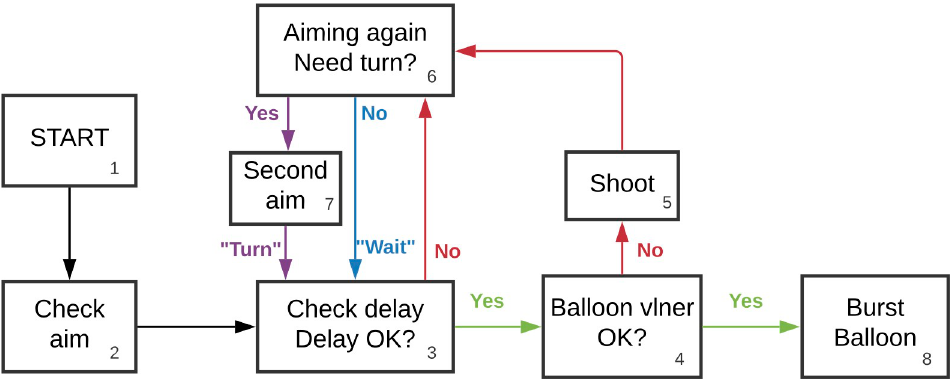
Fig 2. Description of ACT-R operators in Auto Orbit . The diagram is displaying the order in which operators (action rules based on the instructions) were retrieved from the start (balloon respawn–box 1) to the end (balloon burst–box 8) of a game cycle. The “check aim” operator (box 2) checked whether the spaceship was correctly aimed at the balloon. The “check delay” operator (box 3) assessed whether the temporal module time tracker was greater than a given threshold. The “balloon vlner” operator (box 4) assessed whether the vulnerability of the balloon was high enough for ACT-R to execute a double shot (box 8). If it was too low, then ACT-R executed a single shot (box 5). The “aiming again” operator (box 6) assessed whether the ship’s aim was too narrow with respect to the center of the balloon and required an additional turn (box 7) (Note: This diagram was created in Lucidchart, www.lucidchart.com).